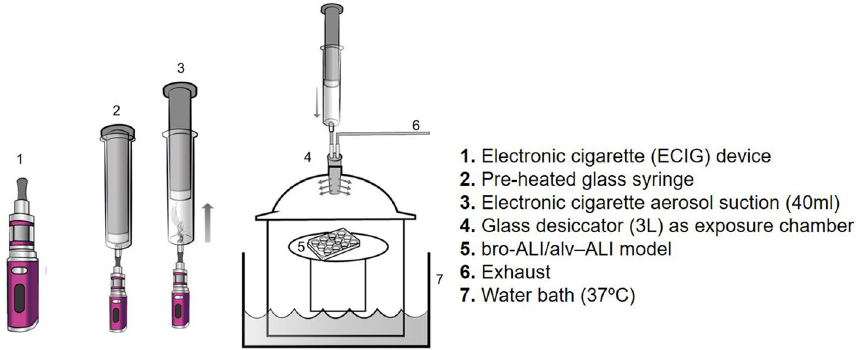
Figure 1. Schematic representation of the electronic cigarette (ECIG) aerosol exposure set up for bronchial (bro-ALI) and alveolar (alv-ALI) mucosa models. A vaping regime mimicking one day of low intensity vaping was applied and consisted of repeated exposure [40 watts (W), 40 ml/puff, 3 s (s) puff duration, 30 s puff interval, 10 puffs/session, bro-ALI model: 6 sessions, alv-ALI model: 3 sessions, 1 h session interval] leading to a total of 60 puffs and 30 puffs for bro-ALI and alv-ALI, respectively. The authors sincerely acknowledge the assistance of Ann-Katrin Sjödén in preparing the